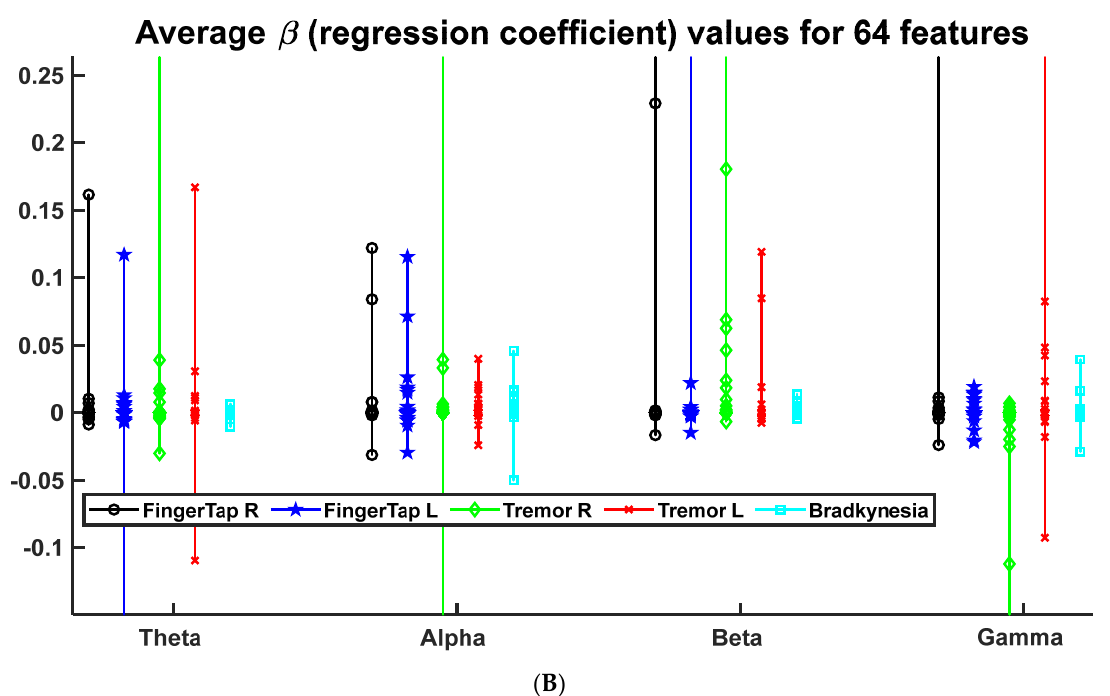
Figure A5. Average values of the LASSO coefficients: ( A ) All the values; ( B ) Zoomed graph of ( A ) for the near zero values.